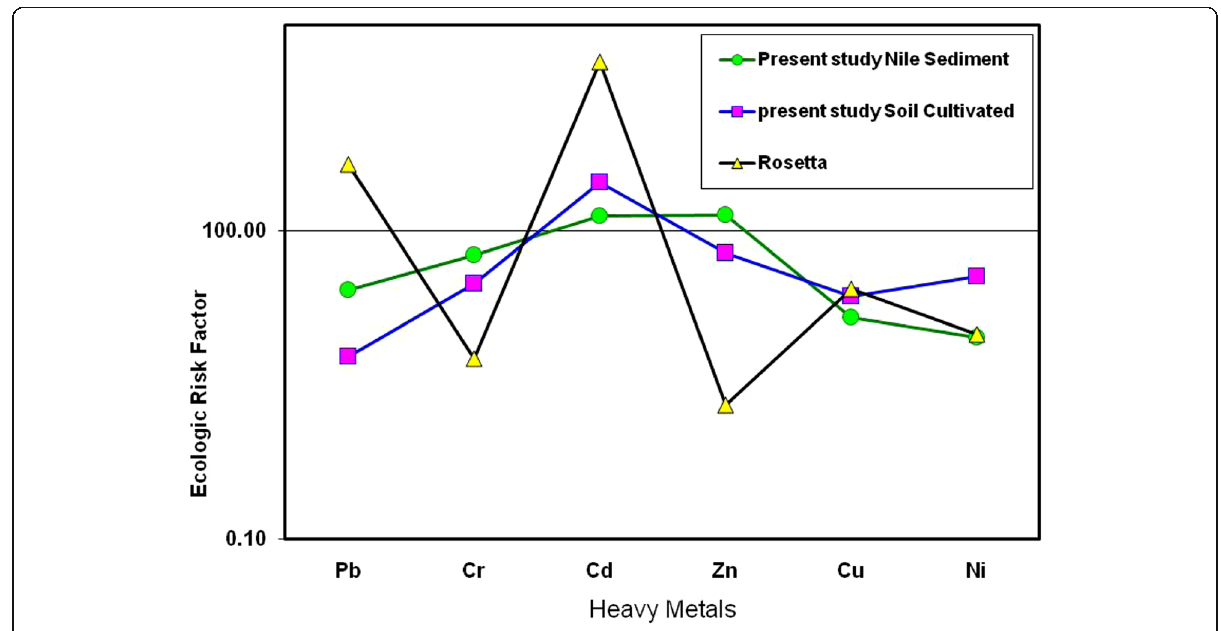
Fig. 9 Comparison of the ecologic risk factor of the study of Nile sediment and soil cultivated with Rosetta